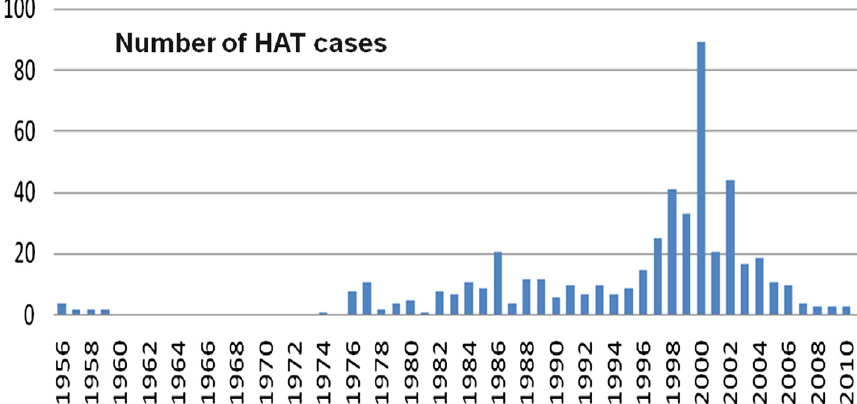
Figure 1. Evolution of the number of HAT cases diagnosed in the Bonon focus from 1956 to